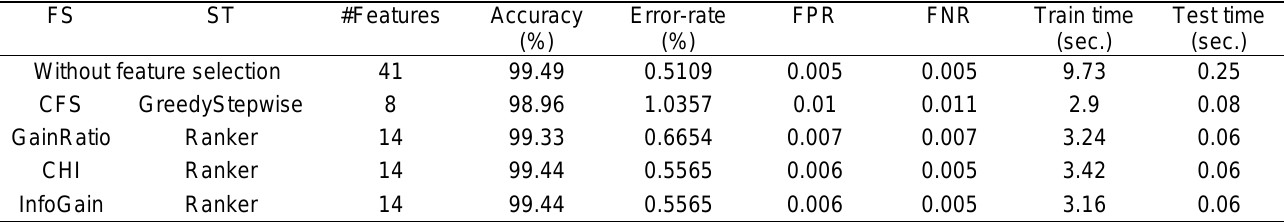
Table 8. Performance evaluation of REPTree classifier using and without using feature selection techniques on